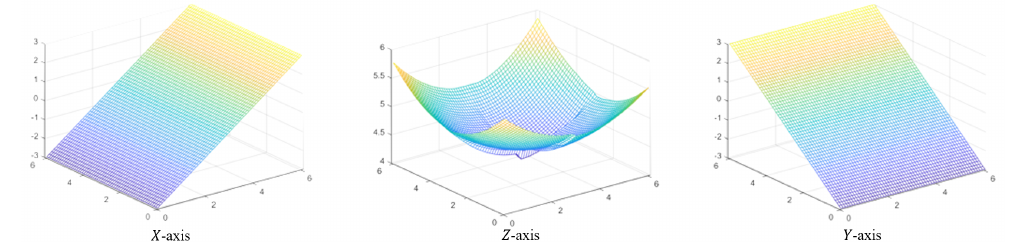
Figure 4. The burden surface